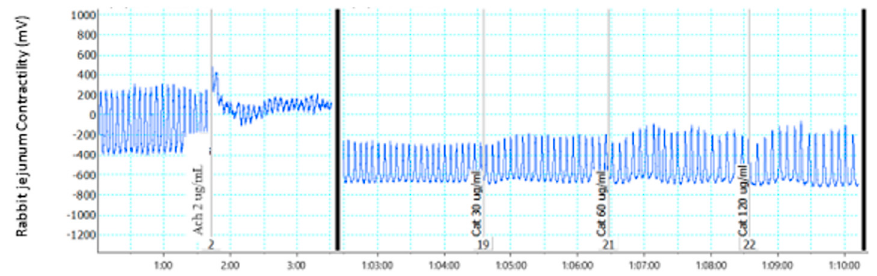
Figure 5. Effect of compound 10 on isolated rabbit jejunum.